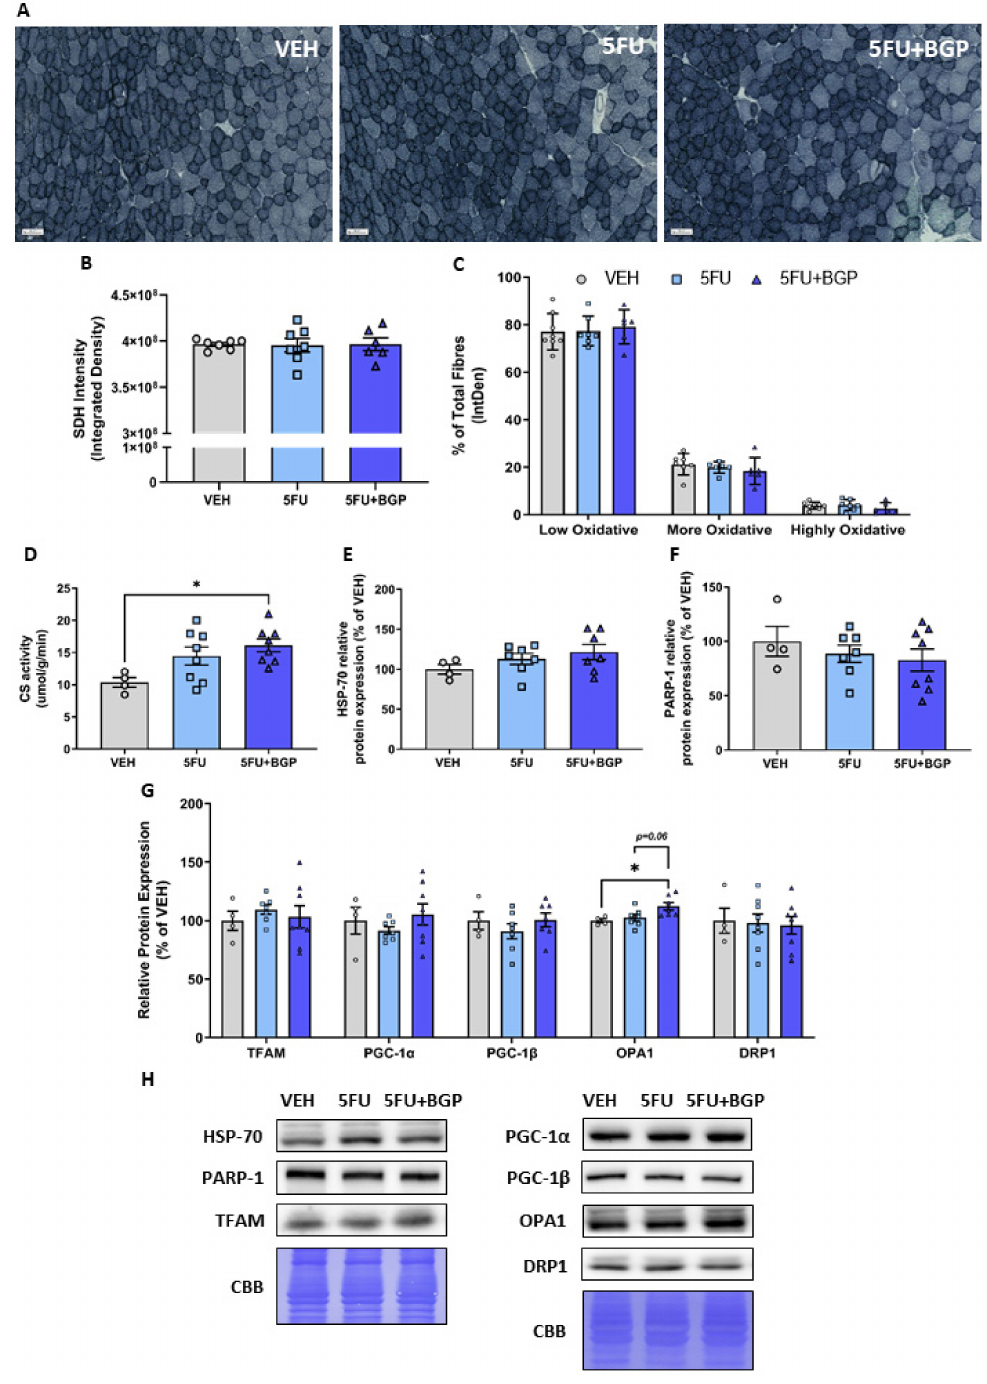
Figure 5. The effect of 5-fluorouracil (5FU) and 5FU with BGP-15 (5FU+BGP) treatment on skeletal muscle oxidative capacity and mitochondrial dynamics signalling. Succinate dehydrogenase (SDH) staining was performed on tibialis anterior (TA) cross-sections. ( A ) SDH representative images displayed, with data presented as ( B ) overall SDH intensity and ( C ) SDH intensity separated based on oxidative fibre phenotype, i.e., low oxidative, more oxidative and highly oxidative. TA muscle homogenate was analyzed for ( D ) citrate synthase (CS) activity, as a marker of mitochondrial density. Further, TA homogenate was utilized in Western blotting experiments with samples probed for ( E ) HSP-70, ( F ) PARP-1 and ( G ) a suite of proteins related to mitochondrial dynamics including; TFAM, PGC-1 α , PGC-1 β , OPA1 and DRP1. Protein expression was normalised to total protein derived from Coomassie Brilliant Blue (CBB) staining and presented relative to vehicle (VEH) control group. ( H ) Western blotting and CBB representative images are displayed. * = p < 0.05; n = 6–8 for SDH histology; n = 4 for VEH and n = 6–8 for 5FU and 5FU+BGP groups for CS activity and Western blotting. Data are mean ±